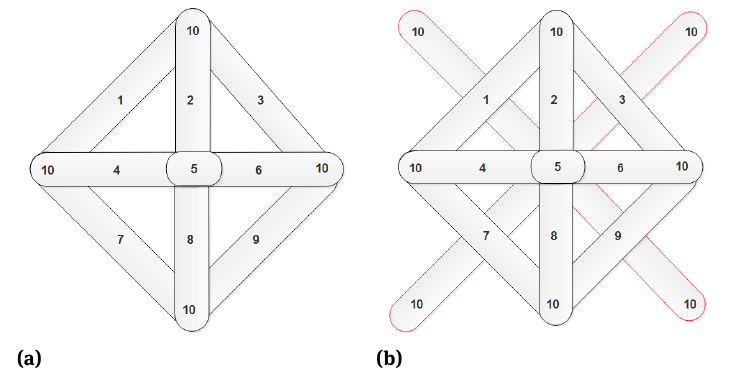
Figure 2: a) Fuzzy set filter pattern, and b) modified fuzzy set filter pattern